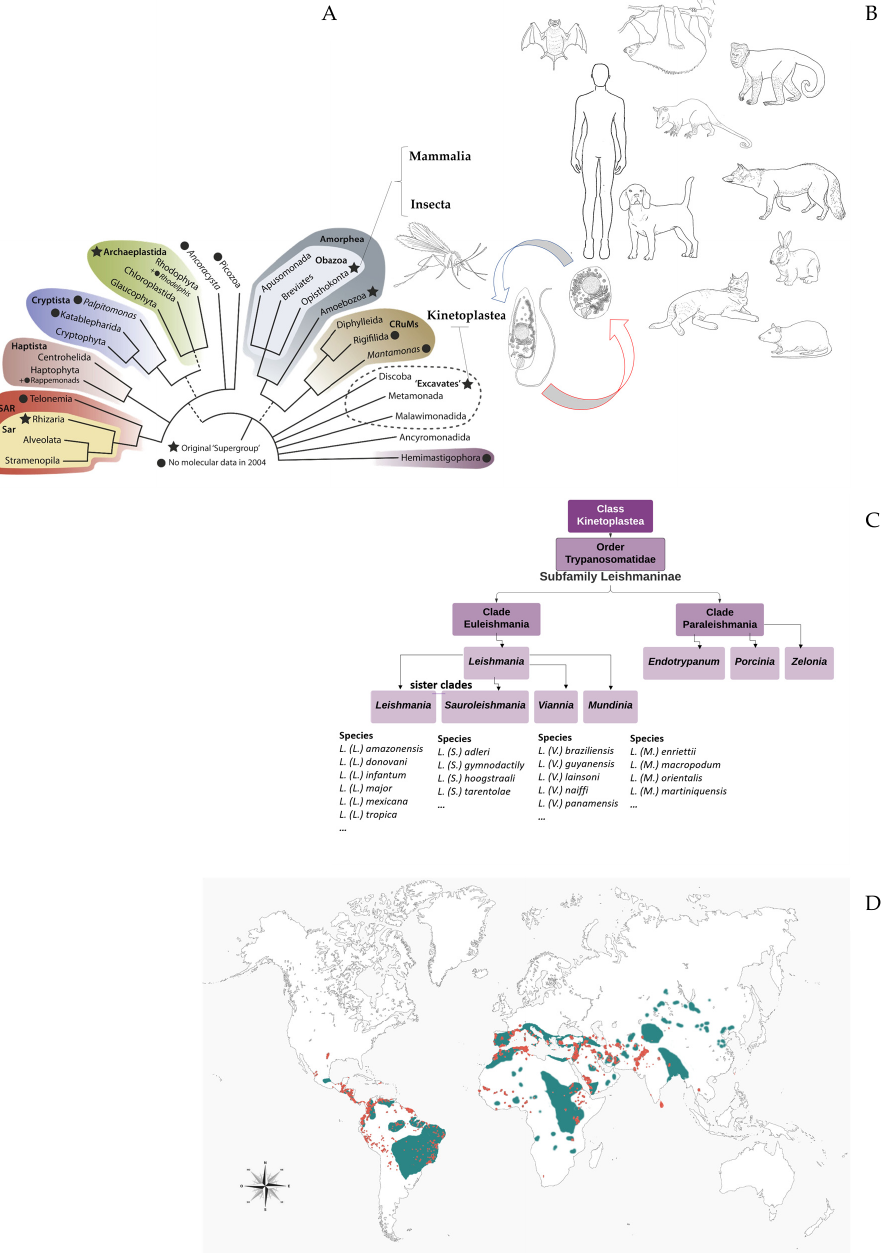
Figure 1. Leishmaniasis (a group of vector-borne zoonotic diseases): parasites, hosts, and epidemio- logical map. ( A ) Eukaryote evolutionary tree focusing on the supergroup Opisthokonta: more